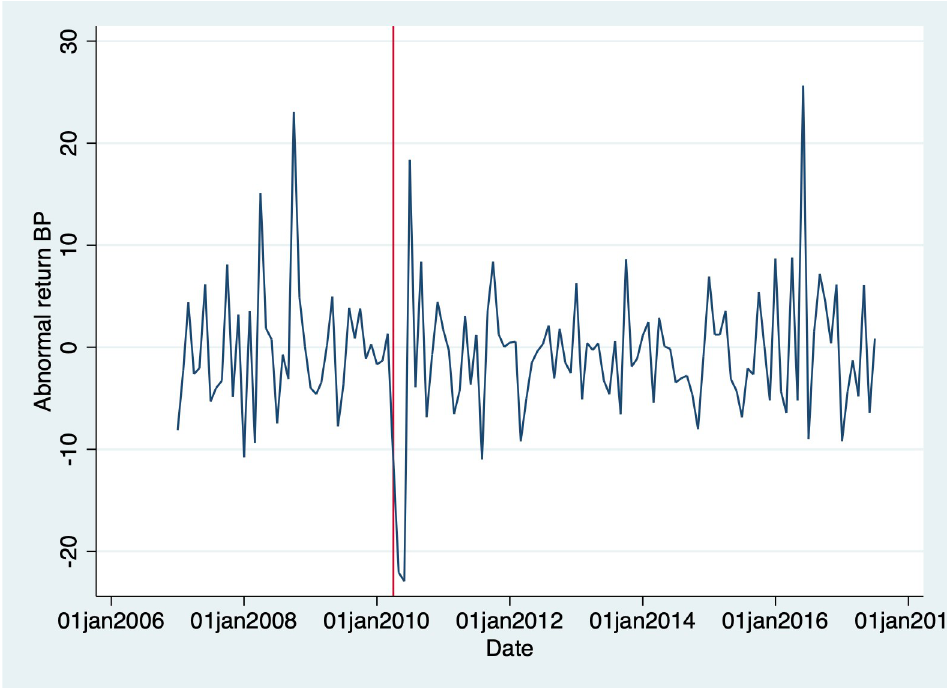
Fig 8. BP’s abnormal